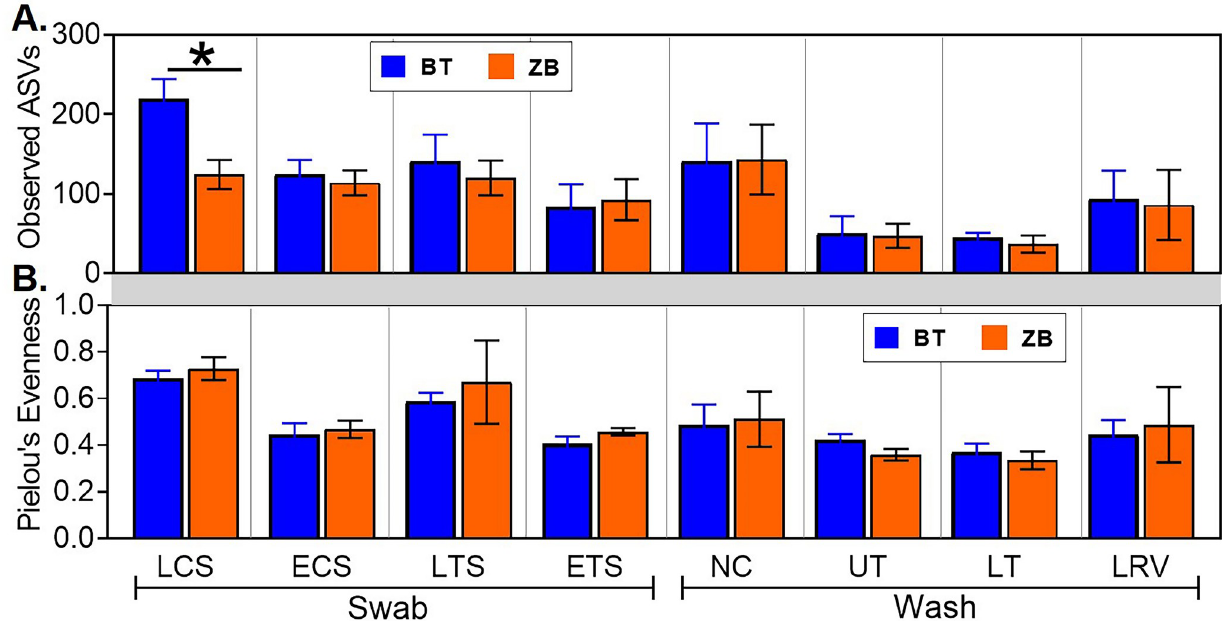
Fig 6. Comparison of alpha diversity metrics from samples extracted using the ZB and BT kits. (A) Species richness was estimated based on the number of observed amplicon sequence variants (ASVs) in each sample. (B) Species evenness in each sample was estimated using Pielou’s evenness index. Statistical differences, � p < 0.05 (pairwise Kruskal-Wallis tests, with a Benjamini-Hochberg correction for false discovery). LCS, live choanal swab; ECS, euthanized choanal swab; LTS, live tracheal swab; ETS, euthanized tracheal swab; NC, nasal cavity wash; UT, upper trachea wash; LT, lower trachea wash; LRV, lower respiratory